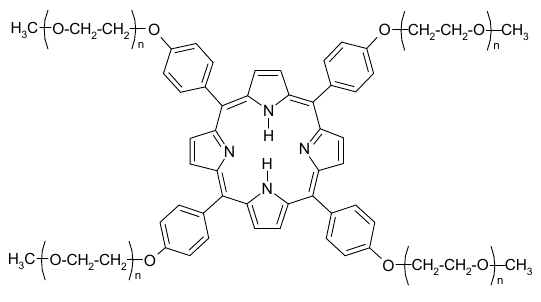
Figure 1. Structure of StarP.